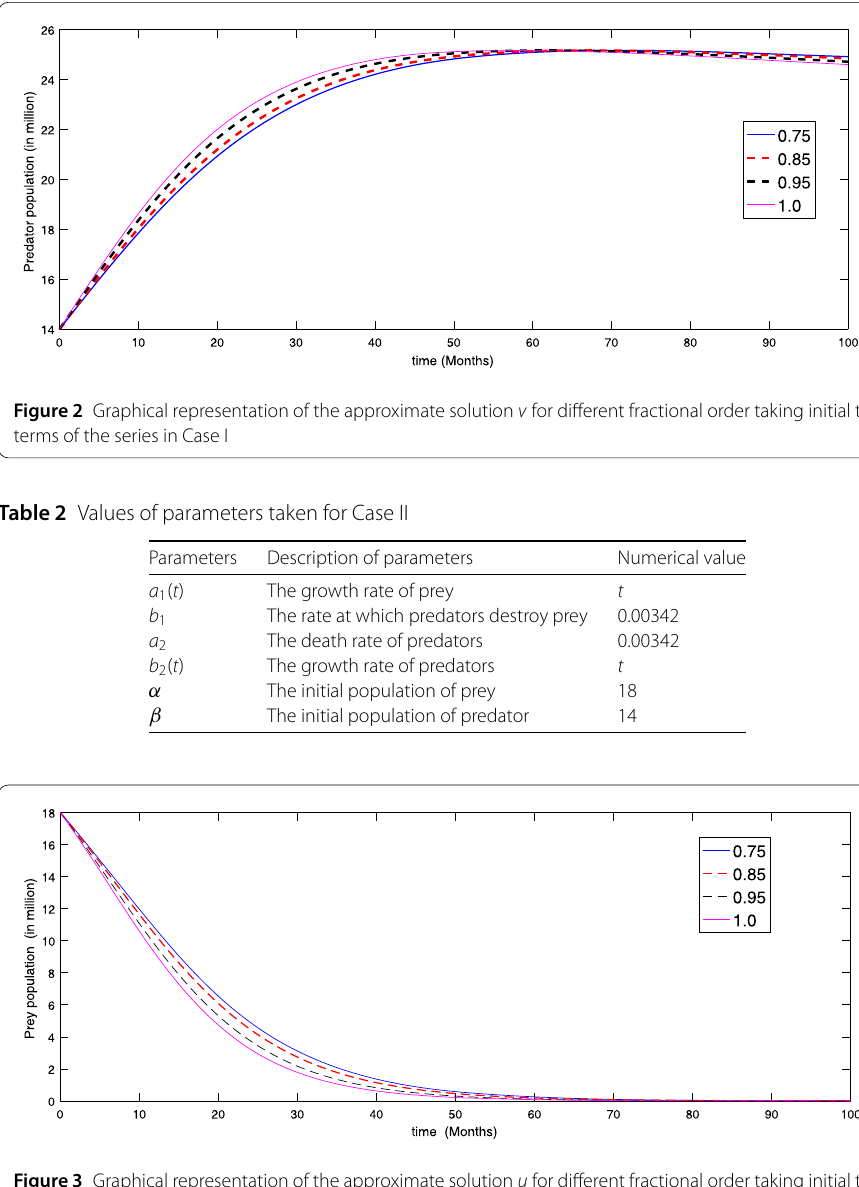
Figure 3 Graphical representation of the approximate solution u for different fractional order taking initial ten terms of the series in Case